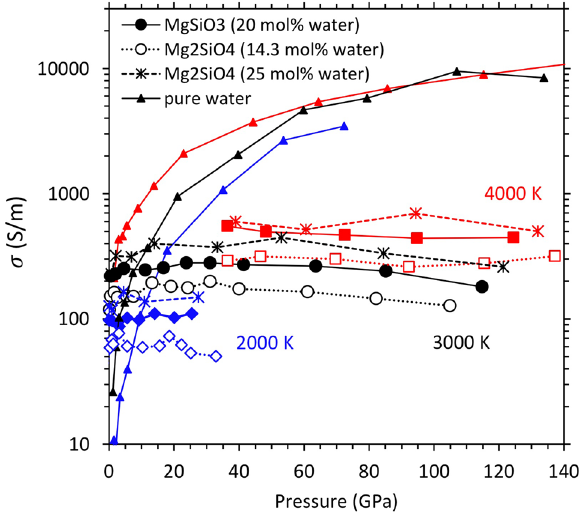
Figure 8. Hydrogen-induced electrical conductivity ( σ ) of hydrous MgSiO 3 (filled symbols) and Mg 2 SiO 4 melts (open symbols and asterisks) and bulk water (solid curves) as a function of pressure at different temperatures as shown. The melt conductivity at 3000 and 4000 K represent the averages taken between the iron-free and iron- bearing compositions (iron has almost no influence on the conductivity, Supplementary Fig. S9). The errors in the calculated electrical conductivity lie within